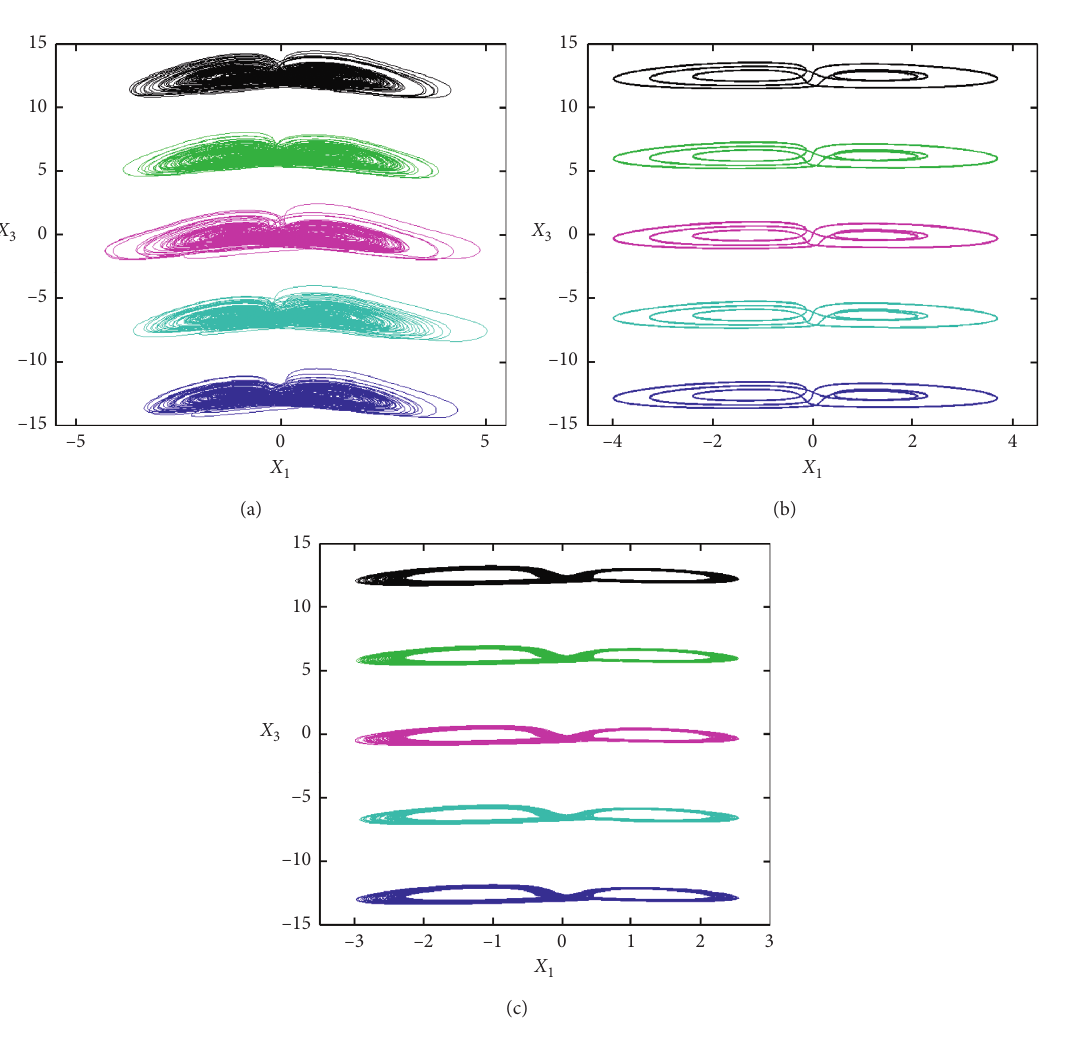
Figure 15: Projections on x − x plane of coexisting attractors obtained from the analog circuit of system (2) for initial voltage of capacitor 1 3 C fixed as ( 1 , 1 , − 6 π ) , ( 1 , 1 , − 4 π ) , ( 1 , 1 , − 2 π ) , ( 1 , 1 , 0 ) , ( 1 , 1 , 2 π ) , and ( 1 , 1 , 4 π ) : (a) coexisting five chaotic attractors; (b) coexisting five 3 periodic attractors; (c) coexisting five quasiperiodic